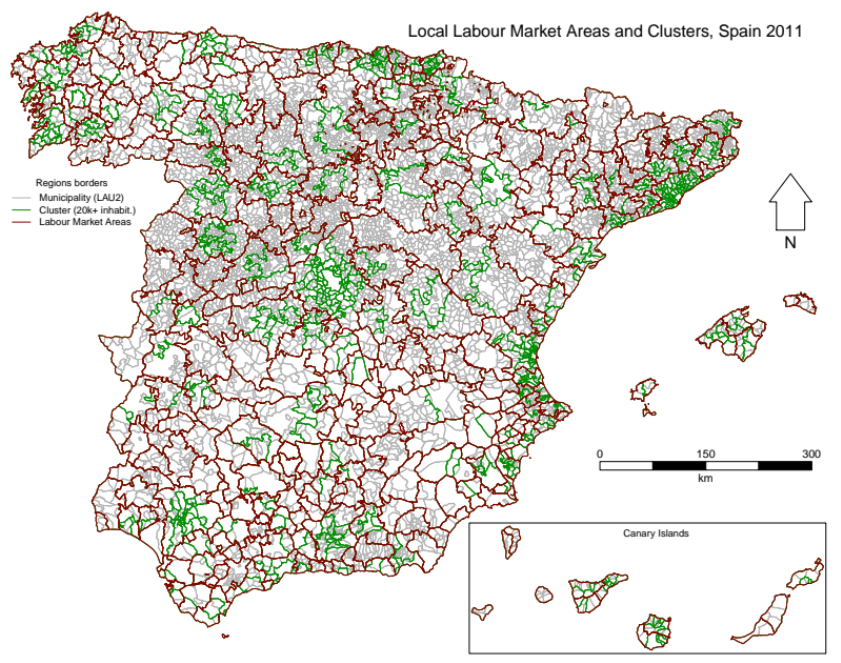
Figure 1: LMA and cluster